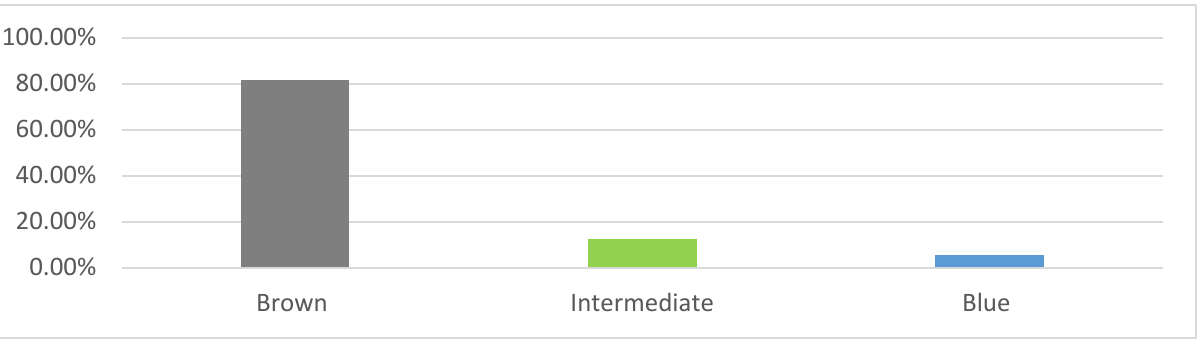
Figure 1. Frequencies of different eye colours.